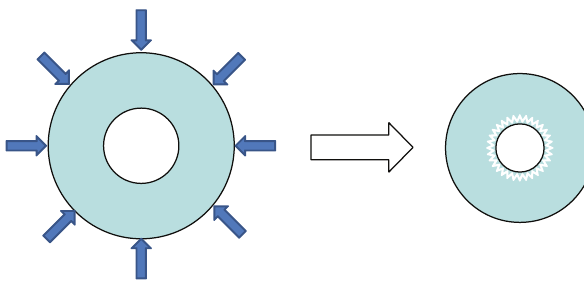
Figure 2: Hollow pore collapse coupled with damage extension under external